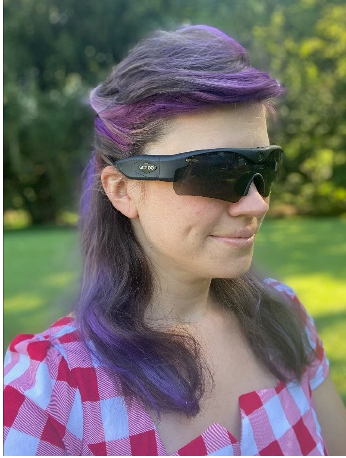
Figure 1. Gogloo E7 SMART WVD. Written informed consent was obtained from the individual for the publication of this image.